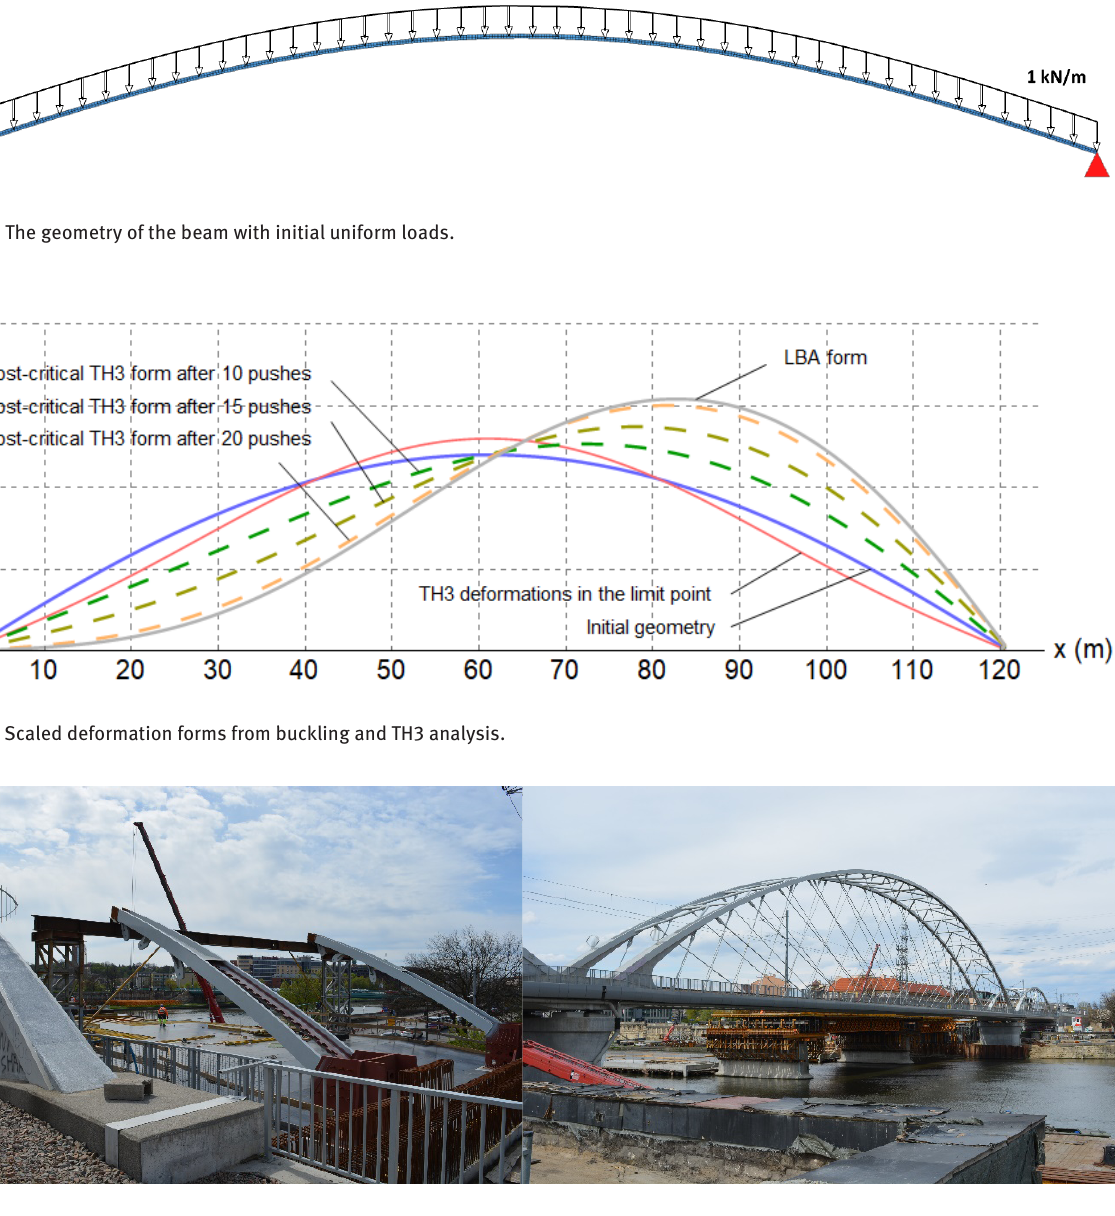
Figure 10: Photos of network arch bridge over Vistula River in Cracow (own